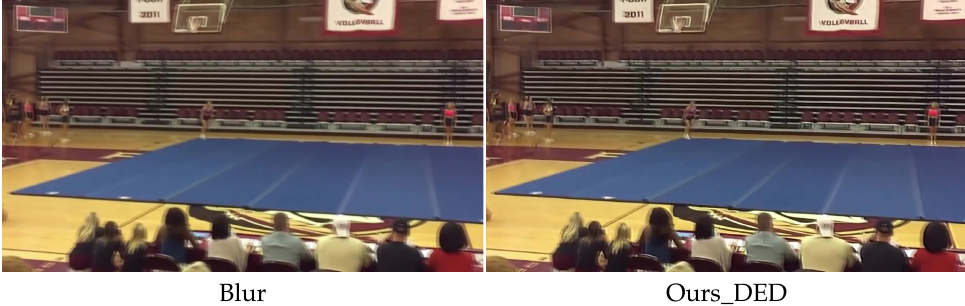
Figure A3. Results of deblurring on Need for Speed [39] with the model trained with GoPro